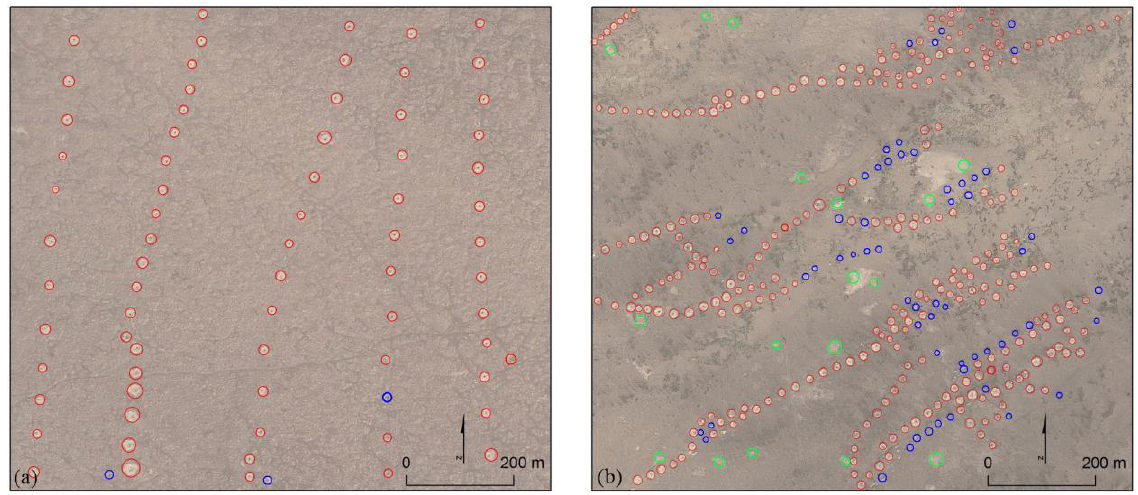
Figure 7. Extracted results of TQSs by the proposed automated approach. ( a ) Test site 1. ( b ) Test site 2. Red circles are extracted TQSs that are also present in the manual ground-truthing catalog, blue are missed TQSs, and green are false